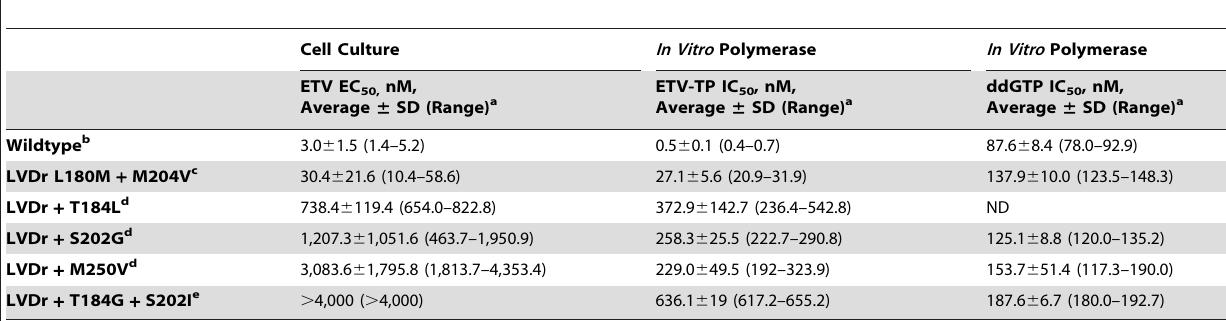
Table 1. Phenotypic ETV Resistance of HBV